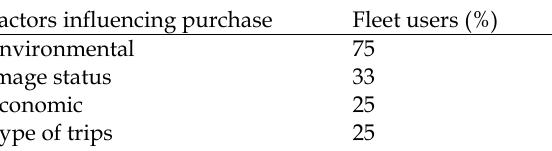
Table 2 Factors influencing companies’ EV purchase decision according to fleet users (percentage of participants)